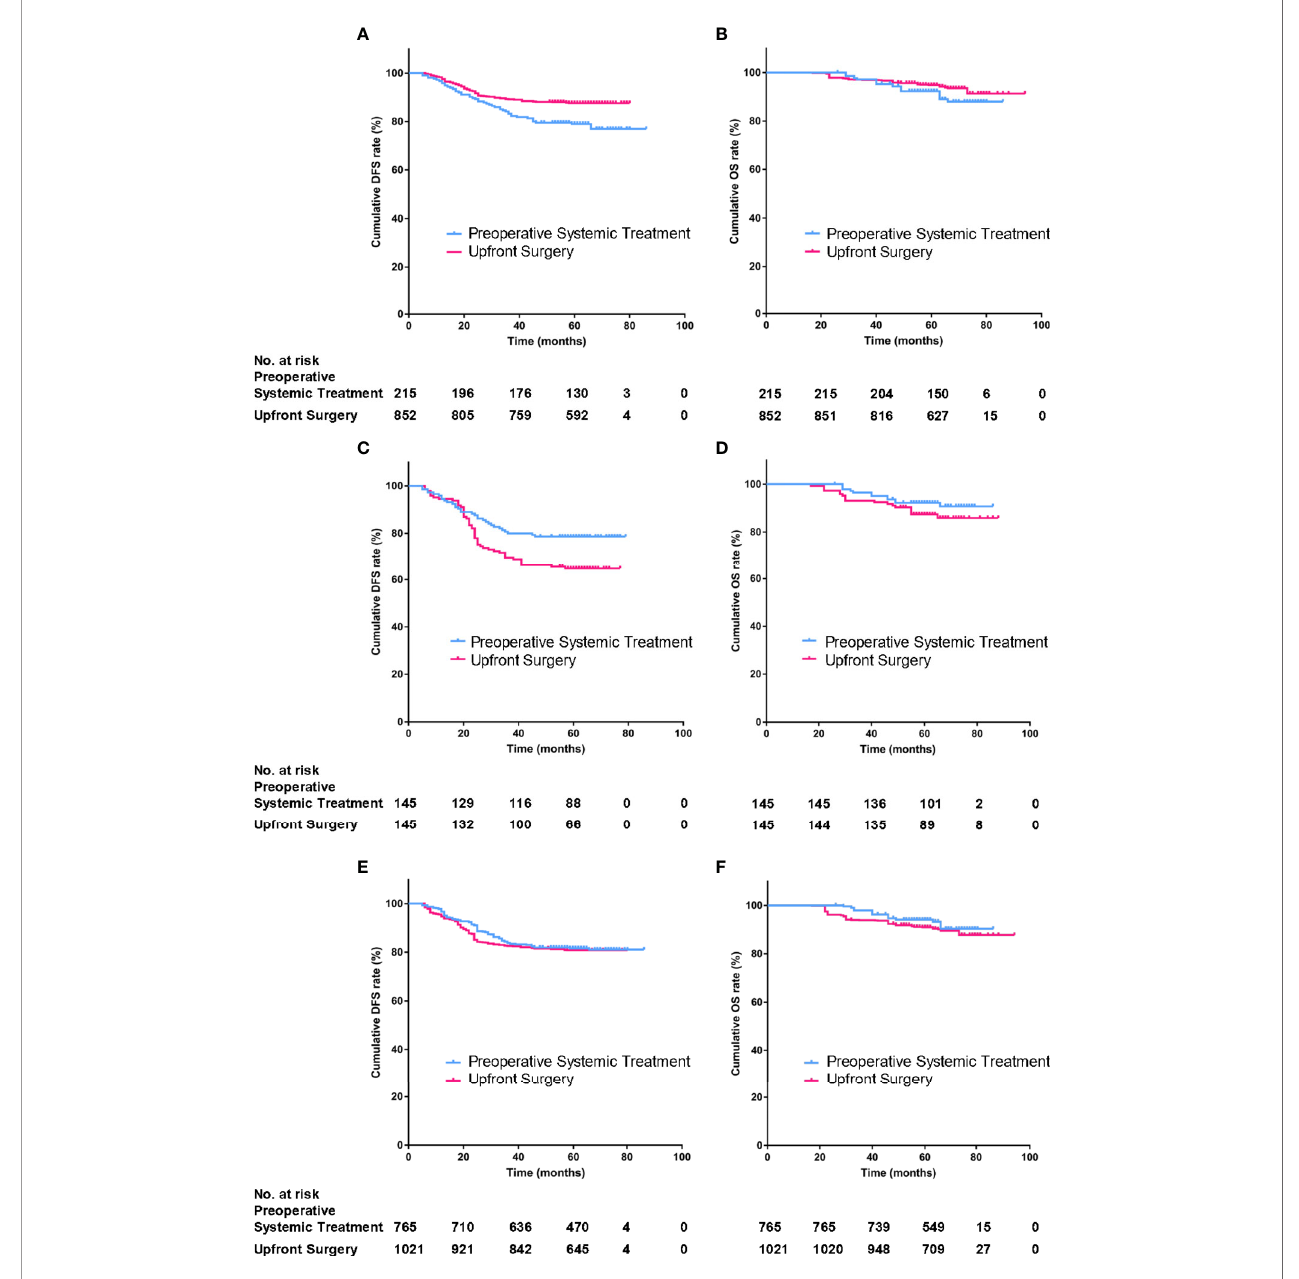
FIGURE 2 | The DFS and OS of preoperative systemic treatment (PST) group and upfront surgery (US) group in primary unmatched model (A, B) in propensity score matching (PSM) model (C, D) , in inverse probability of treatment weighting (IPTW) model (E, F)